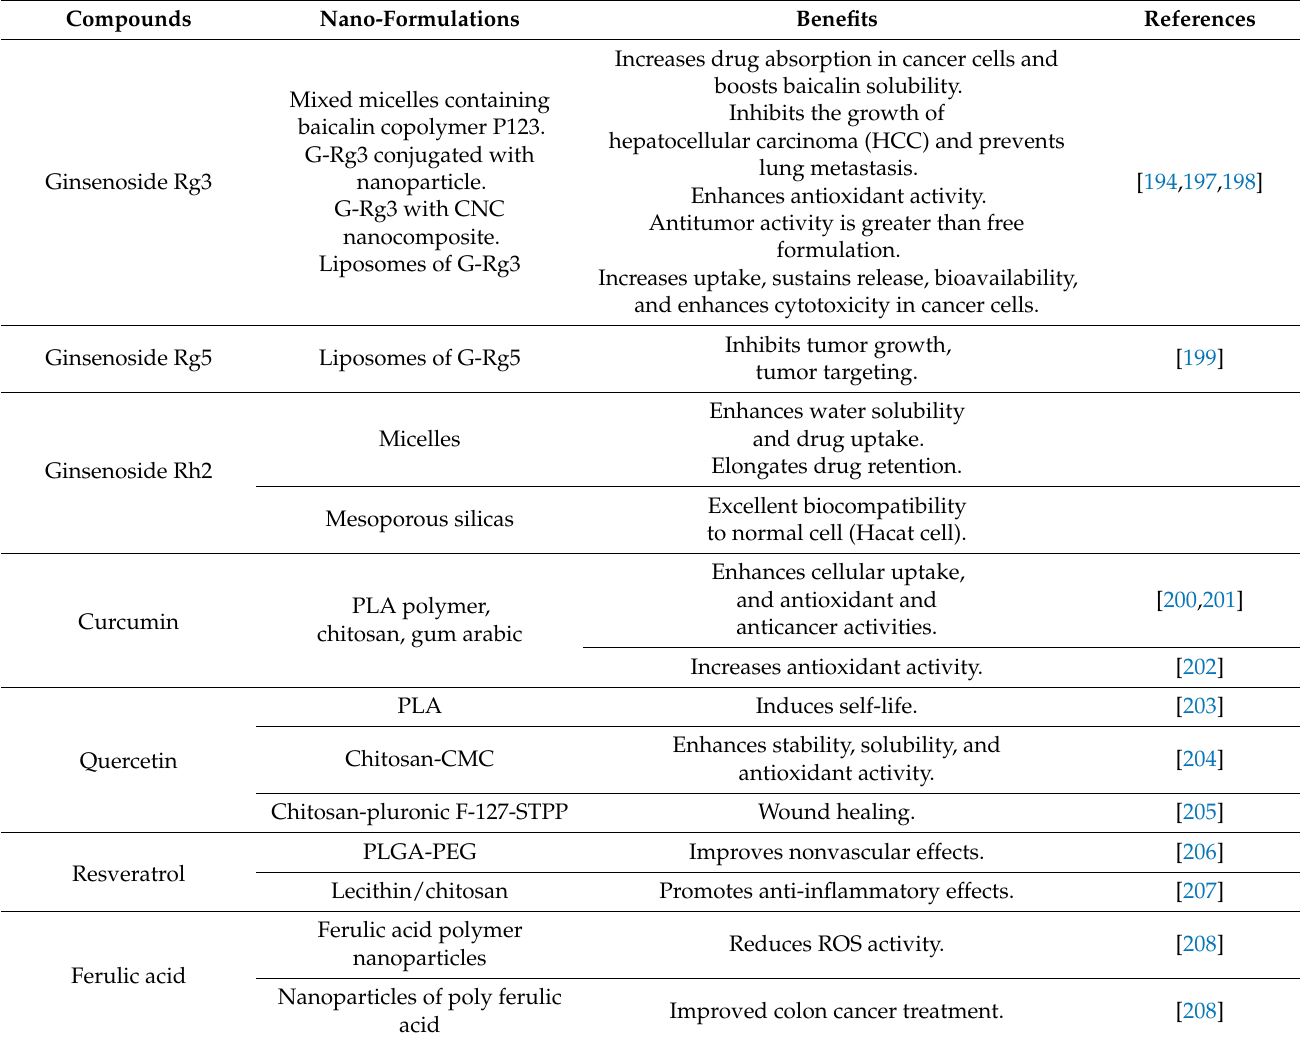
Table 3. Nano-formulations of active